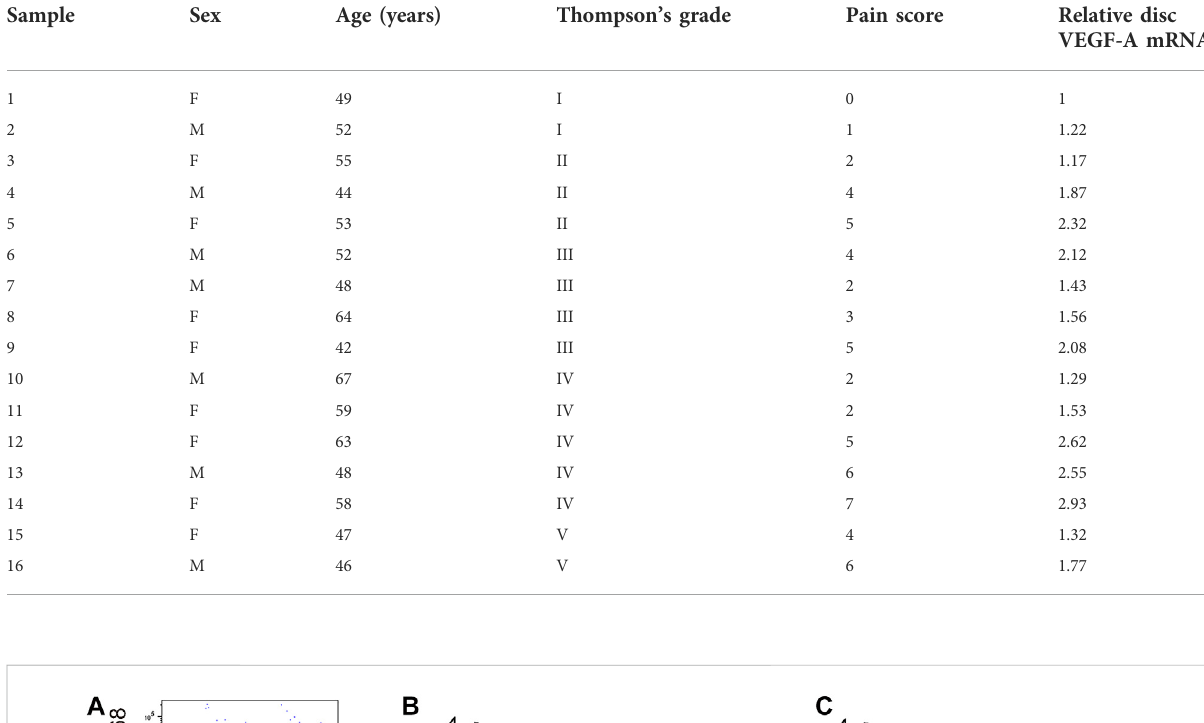
TABLE 1 Demographic details of Intervertebral disc donors.